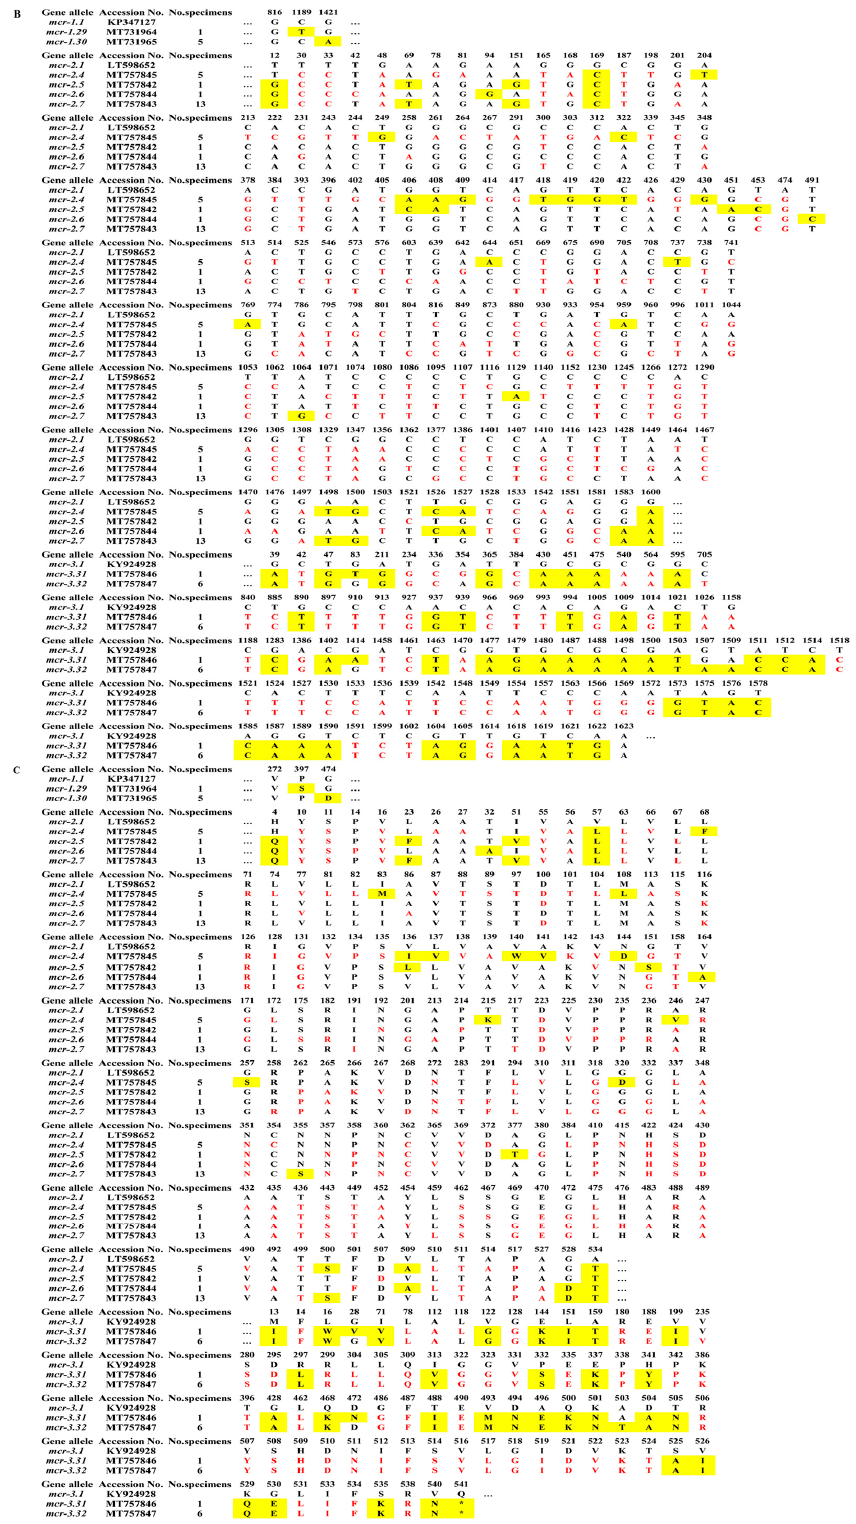
2 Figure 3. Cluster analysis of mcr genotypes ( A ) and nucleotide (nt) and amino acid (aa) alignments of new mcr subtypes ( B , C ). ( A ) Phylogenic tree of mcr-1 to mcr-4 based on nt sequences. (continued). ( B ) nt mutations of new mcr subtypes. Sense mutation is shown in yellow, nonsense mutation is shown in red. ( C ) aa mutations of new mcr subtypes. Sense mutation is shown in yellow, nonsense mutation is shown in red. * termination